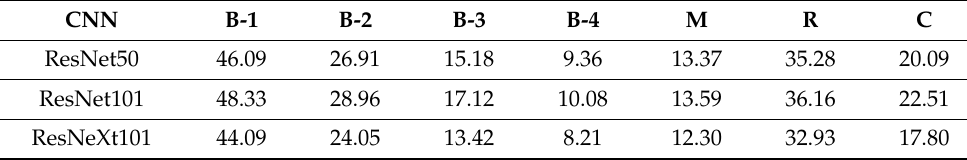
Table 3. Performance on test splits for Baseline-B model.